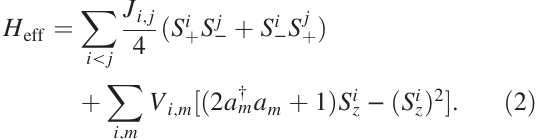
FIG. 1. (a) Level diagram for 171 Yb þ , highlighting relevant states. (b) Sketch of experimental geometry, showing the direc- tions of the laser wave vectors and the real magnetic field relative to the ion chain. Both beams are linearly polarized, one along the ~ B field (providing π light) and one orthogonal to the (providing an equal superposition of σ þ and σ − light). Multiple beat notes are applied by imprinting multiple frequencies onto one beam (in this case, the π -polarized beam). (c) Detailed level diagram of the 2 S 1 = 2 ground state, showing Raman beat notes in relation to Zeeman splittings and motional sidebands for the center-of-mass mode. Level splittings are not to